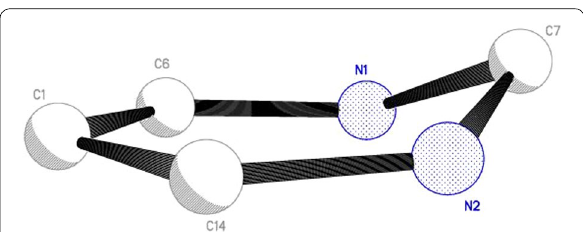
Fig. 9 Molecular structure of OCT compound